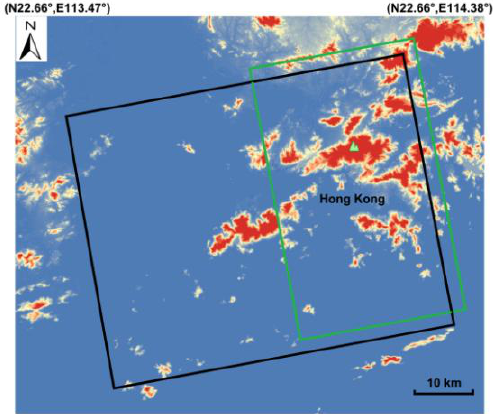
Figure 1. Coverage of ALOS PALSAR (marked by the black box) and TerraSAR-X data (marked by the green box) in Hong Kong, indicating the former has larger swath than the latter. Background is the SRTM DEM-shaded image, and Tai Mo Shan is marked by the light green mountain